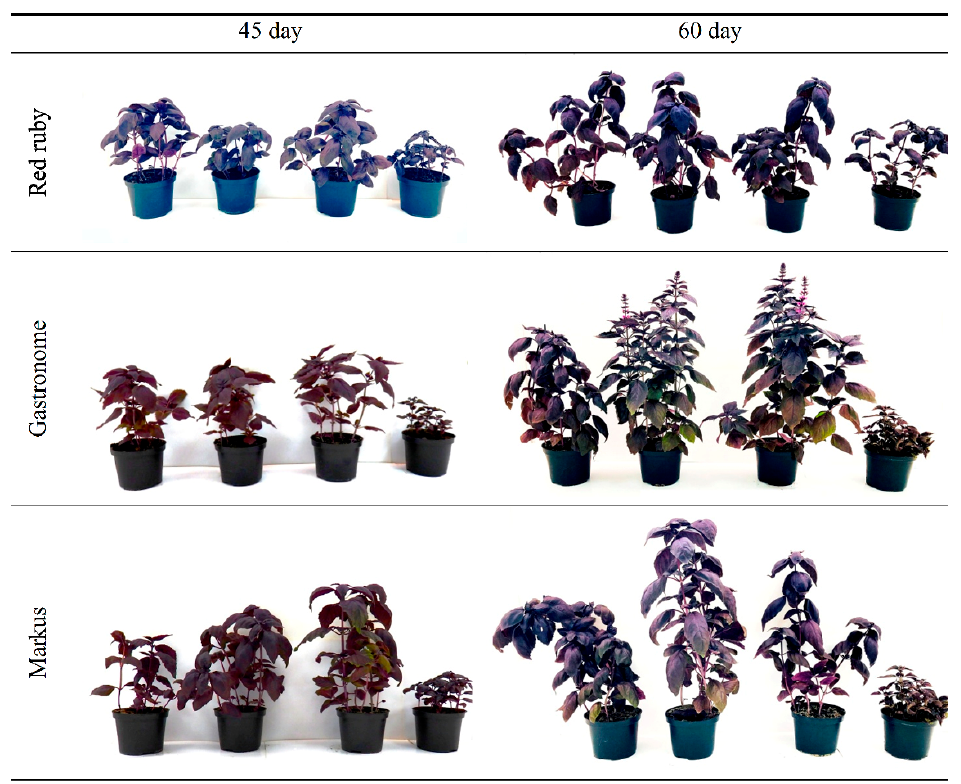
Figure 1. Basil plants of varieties “Red Ruby”, “Gastronome” and “Markus” on 45th and 60th days of cultivation; from left to right: control, UV-A, UV-B, and UV-C.